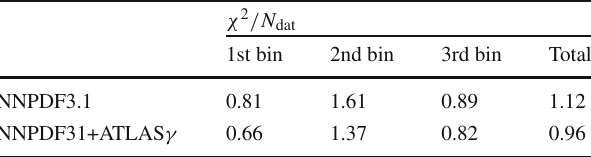
Table 3 The χ 2 / N dat values for the 8 TeV ATLAS data for the NNPDF3.1 and NNPDF3.1 + ATLAS γ fits, both for three rapidity bins included in the fit and for their total